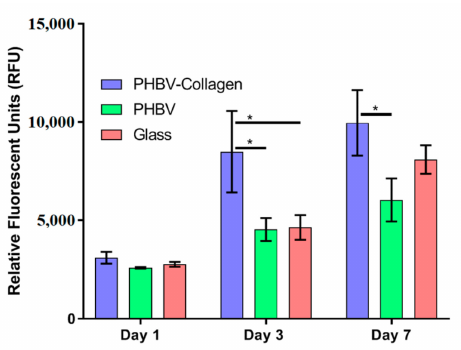
Figure 7. Relative fluorescent output of metabolised presto blue, representative of the cellular metabolic activity on sca ff olds (* p <